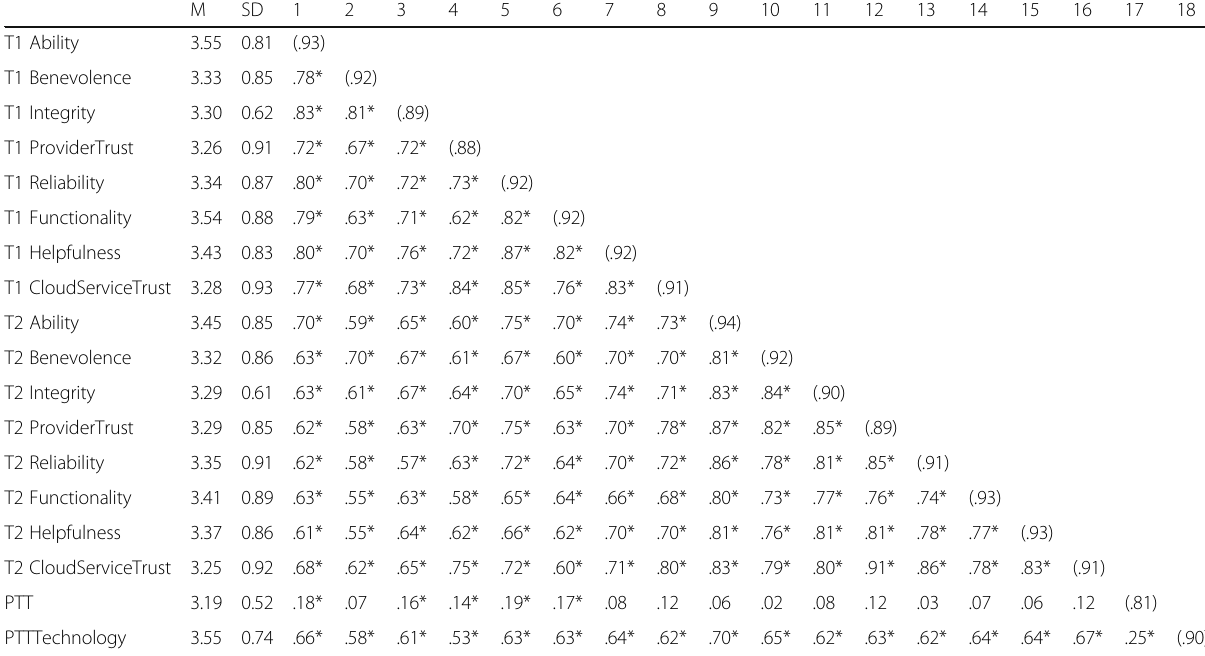
Table 2 Correlations and Descriptive Statistics for Key Study